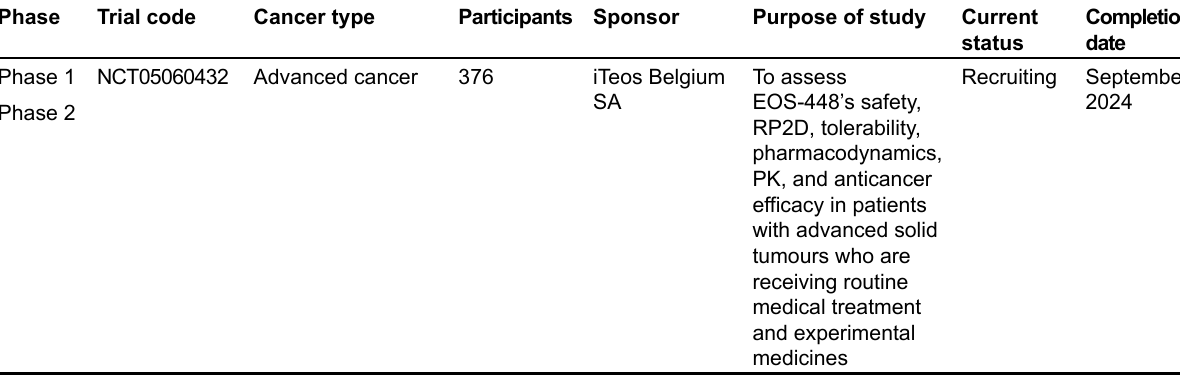
Table 2. Trials of dostarlimab ( continued ) Phase Trial